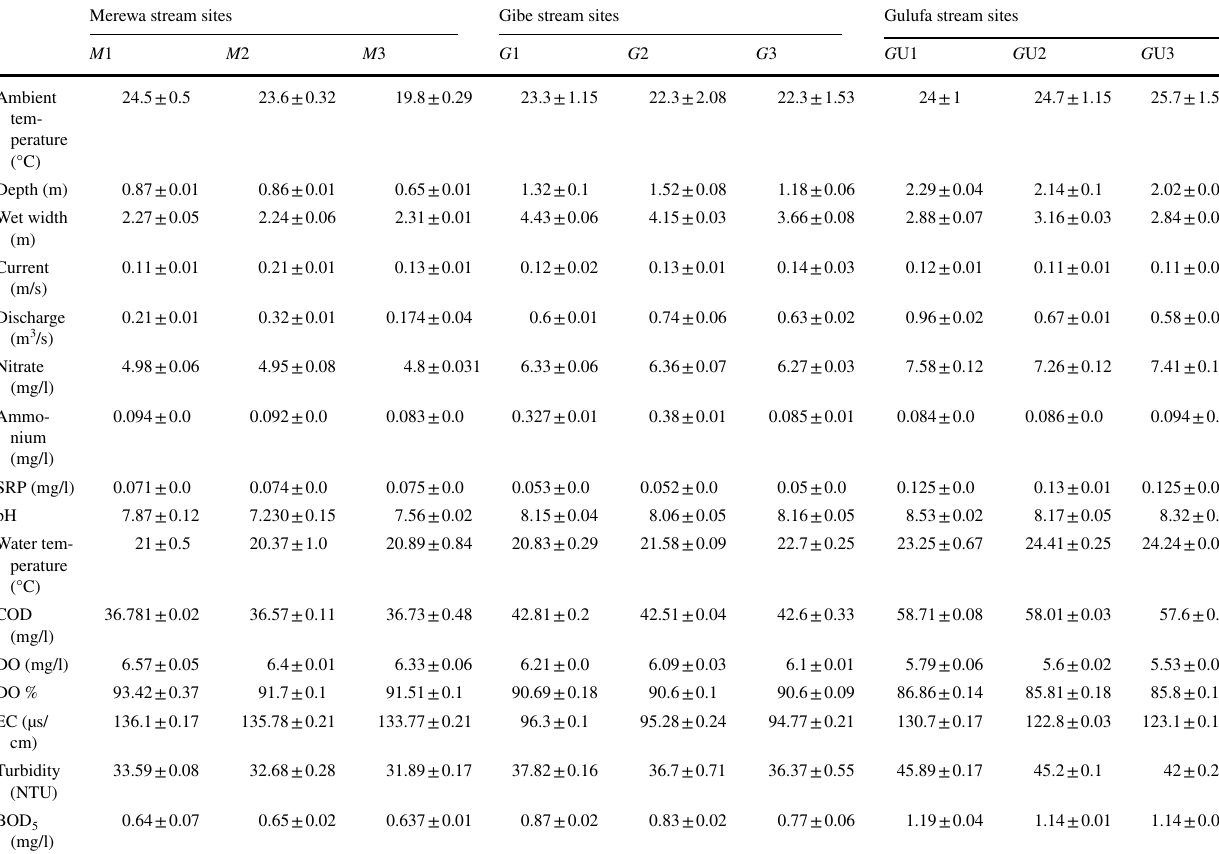
Table 1 Mean (± SE) values for measured physicochemical characteristics of nine study sites in agriculture catchment Merewa stream